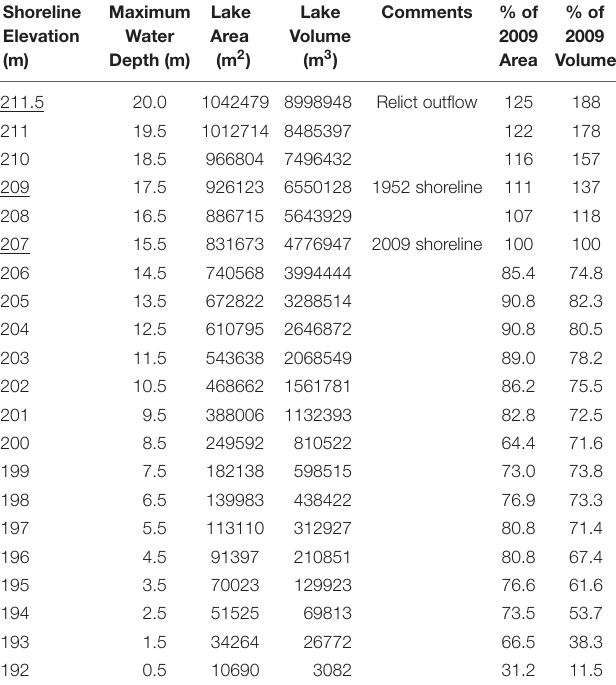
TABLE 1 | Greenpepper Lake hypsometric